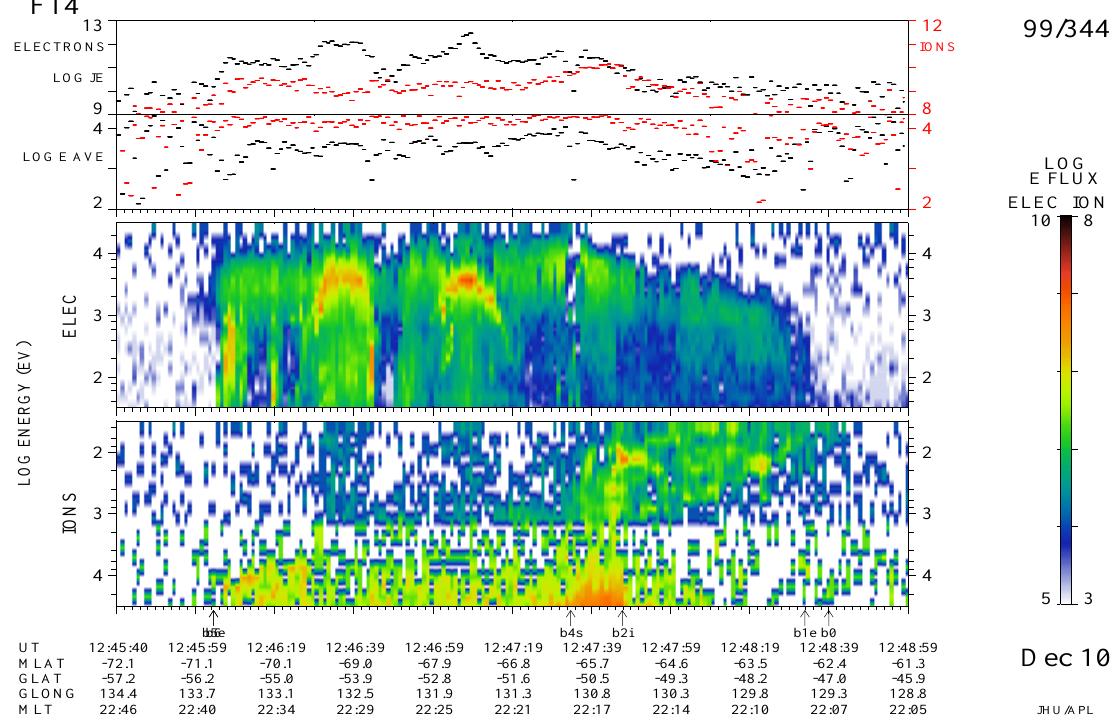
Fig. 6. Spectrograms calculated from 1s resolution measurements of precipitating ions and electrons made with the SS J/4 detector on board the DMSP F14 spacecraft during 12:45:40 to 12:48:59UT on 10 December 1999. The top and second panels show the base-10 logarithms of the integral energy flux (eVcm − 2 s − 1 ster − 1 ), and average energy (eV) carried by the ions (red) and electrons (black), respectively. The bottom two panels show the spectra of differential energy flux (eVcm − 2 s − 1 ster − 1 eV − 1 ) for the precipitating ions and electrons, again on logarithmic scales. Note that ion energy increases downwards. The abscissa is annotated with universal time (UT), magnetic latitude (MLAT), geographic latitude (GLAT), geographic longitude (GLONG), and the magnetic local time (MLT). The nominal OCB corresponds to the boundary b5e (near 12:45:59UT), the transition between discrete and diffuse aurora to the boundary b4s (near 12:47:39UT), and the plasmapause in proximity to the boundaries b1e and b0 (near